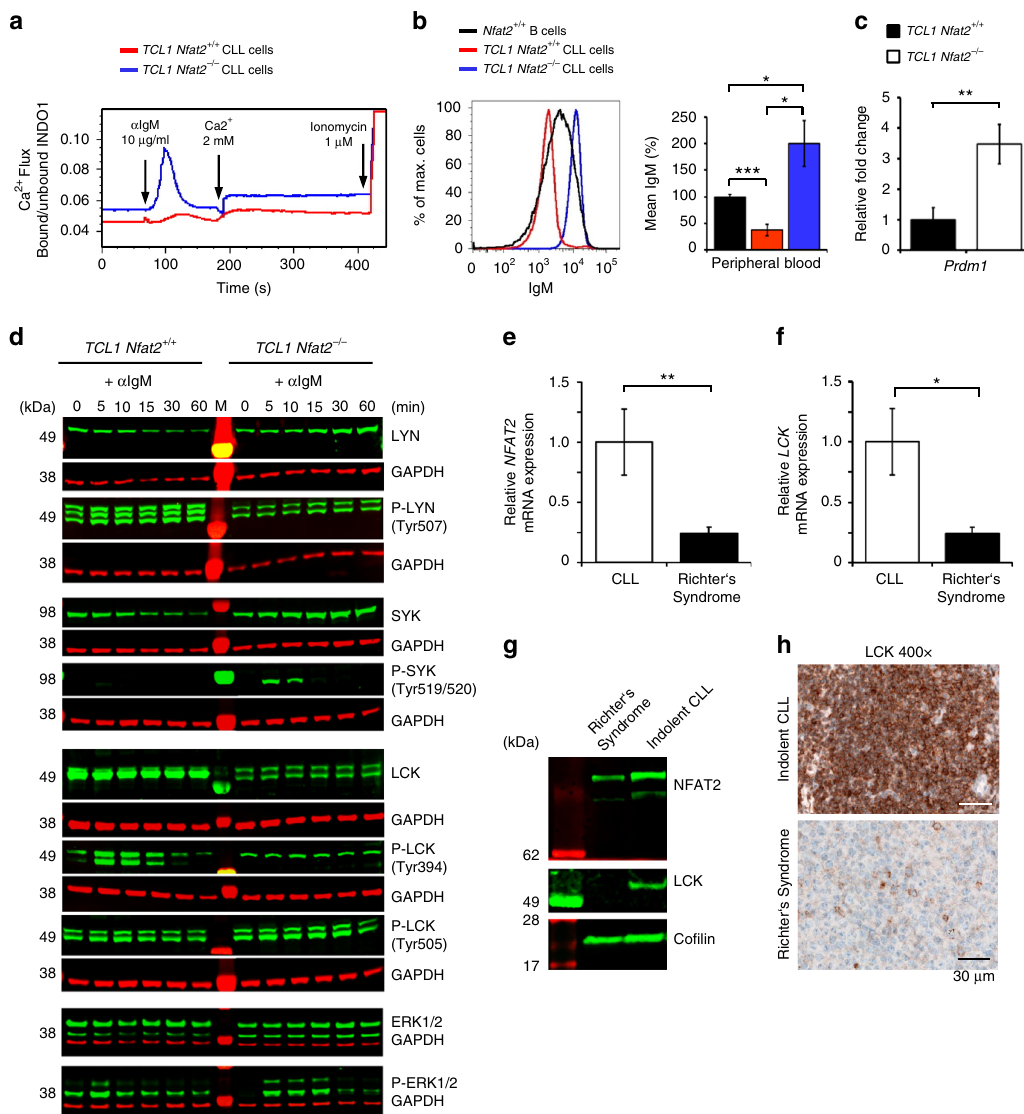
Fig. 7 NFAT2 controls the anergic phenotype in CLL. a Ca 2+ fl ux of splenic CD19 + CD5 + CLL cells from 28-week-old TCL1 Nfat2 +/+ and TCL1 Nfat2 − / − mice after stimulation with 10 µ g/ml α IgM. Ca 2+ was added after 3 min for extracellular fl ux. 1 µ M ionomycin was added as a positive control. One representative result of three independent experiments is shown. b IgM surface expression on B cells from 28-week-old Nfat2 +/+ , TCL1 Nfat2 +/+ and TCL1 Nfat2 − / − mice determined by fl ow cytometry ( n = 5 per group). A representative histogram plot ( left panel ) and a statistical analysis of all animals ( right panel ) are shown (Student ’ s t -test, mean ± S.E.M., * P < 0.05, *** P < 0.005). c Relative Prdm1 mRNA expression normalised to Actin in ex vivo splenic CLL cells from 28-week-old TCL1 Nfat2 +/+ and TCL1 Nfat2 − / − mice ( n = 6 per group) assessed by qRT-PCR (Student ’ s t -test, mean ± S.E.M., ** P < 0.01). d Splenic CD19 + CD5 + CLL cells from 20-week-old TCL1 Nfat2 +/+ and TCL1 Nfat2 − / − mice were stimulated in vitro with 20 µ g/ml α IgM for the time points indicated. Total protein levels and phosphorylation status of LYN (Tyr507), SYK (Tyr519/520), LCK (Tyr394 and Tyr505) and ERK1/2 (Thr202/Tyr204 Thr185/Tyr187) were assessed by western blotting. One representative result of three independent experiments is shown. e Paraf fi n-embedded lymph node biopsies from human patients with CLL ( n = 5) and Richter ’ s syndrome ( n = 9) were analysed for relative NFAT2 mRNA expression normalised to GAPDH using qRT-PCR (Mann – Whitney test, Mean ± S.E.M., ** P < 0.01). f Paraf fi n-embedded lymph node biopsies from human patients with CLL ( n = 5) and Richter ’ s syndrome ( n = 9) were analysed for relative LCK mRNA expression normalised to GAPDH using qRT-PCR (Student ’ s t -test, mean ± S.E.M., * P < 0.05). g NFAT2 and LCK protein expression in one representative patient with indolent CLL ( left ) and one patient with Richter ’ s syndrome ( right ). h Immunohistochemical staining for LCK of a representative lymph node with indolent CLL and Richter ’ s Syndrome